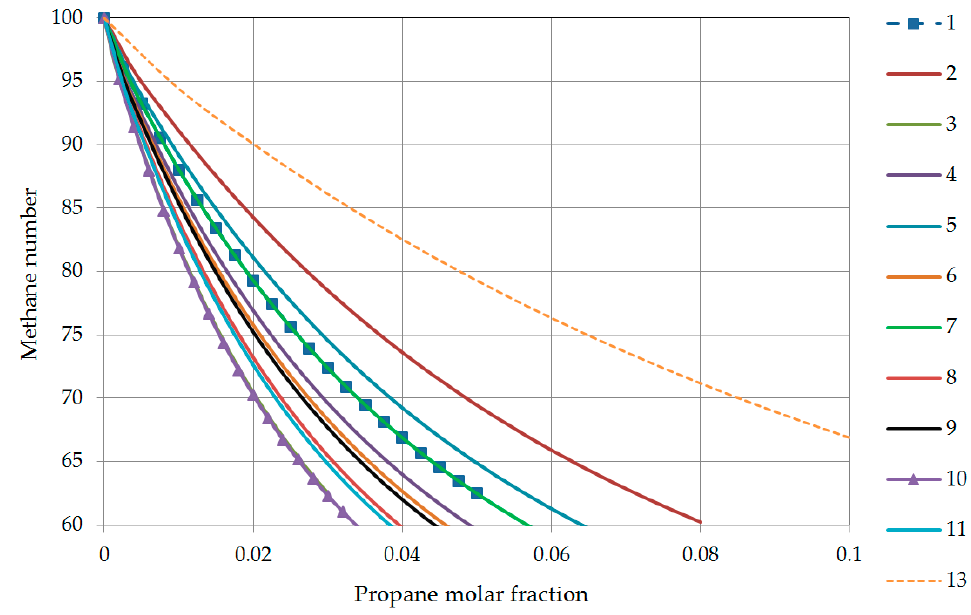
Figure 4. Methane number as function of propane molar fraction in analyzed LNG composition sets .